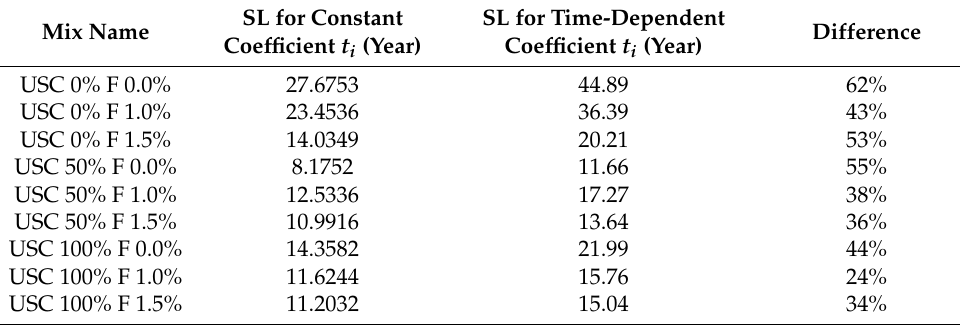
Figure 5. Chloride concentration over time regarding the time-dependent diffusion parameters. Table 7. Results of service life-time exceeded the threshold